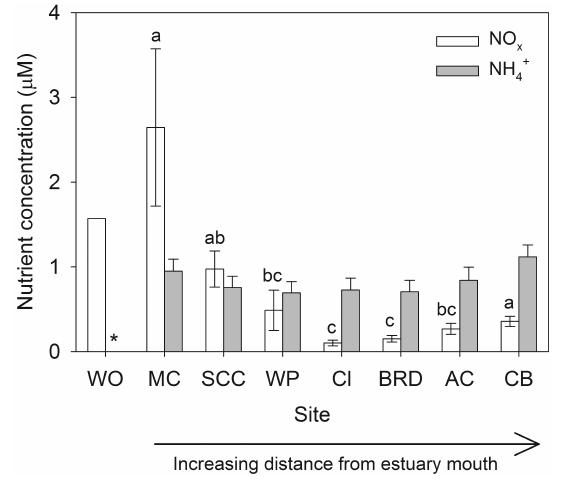
Figure 2. Mean concentration of NO x and NH + Letters indicate differences between sites for NO x concentrations, with sites sharing the same letter being not significantly different. Error bars represent one standard error ( N = 17). Asterisk at WO indicates that mean value of NH 4 was below the limit of quantifica- tion.